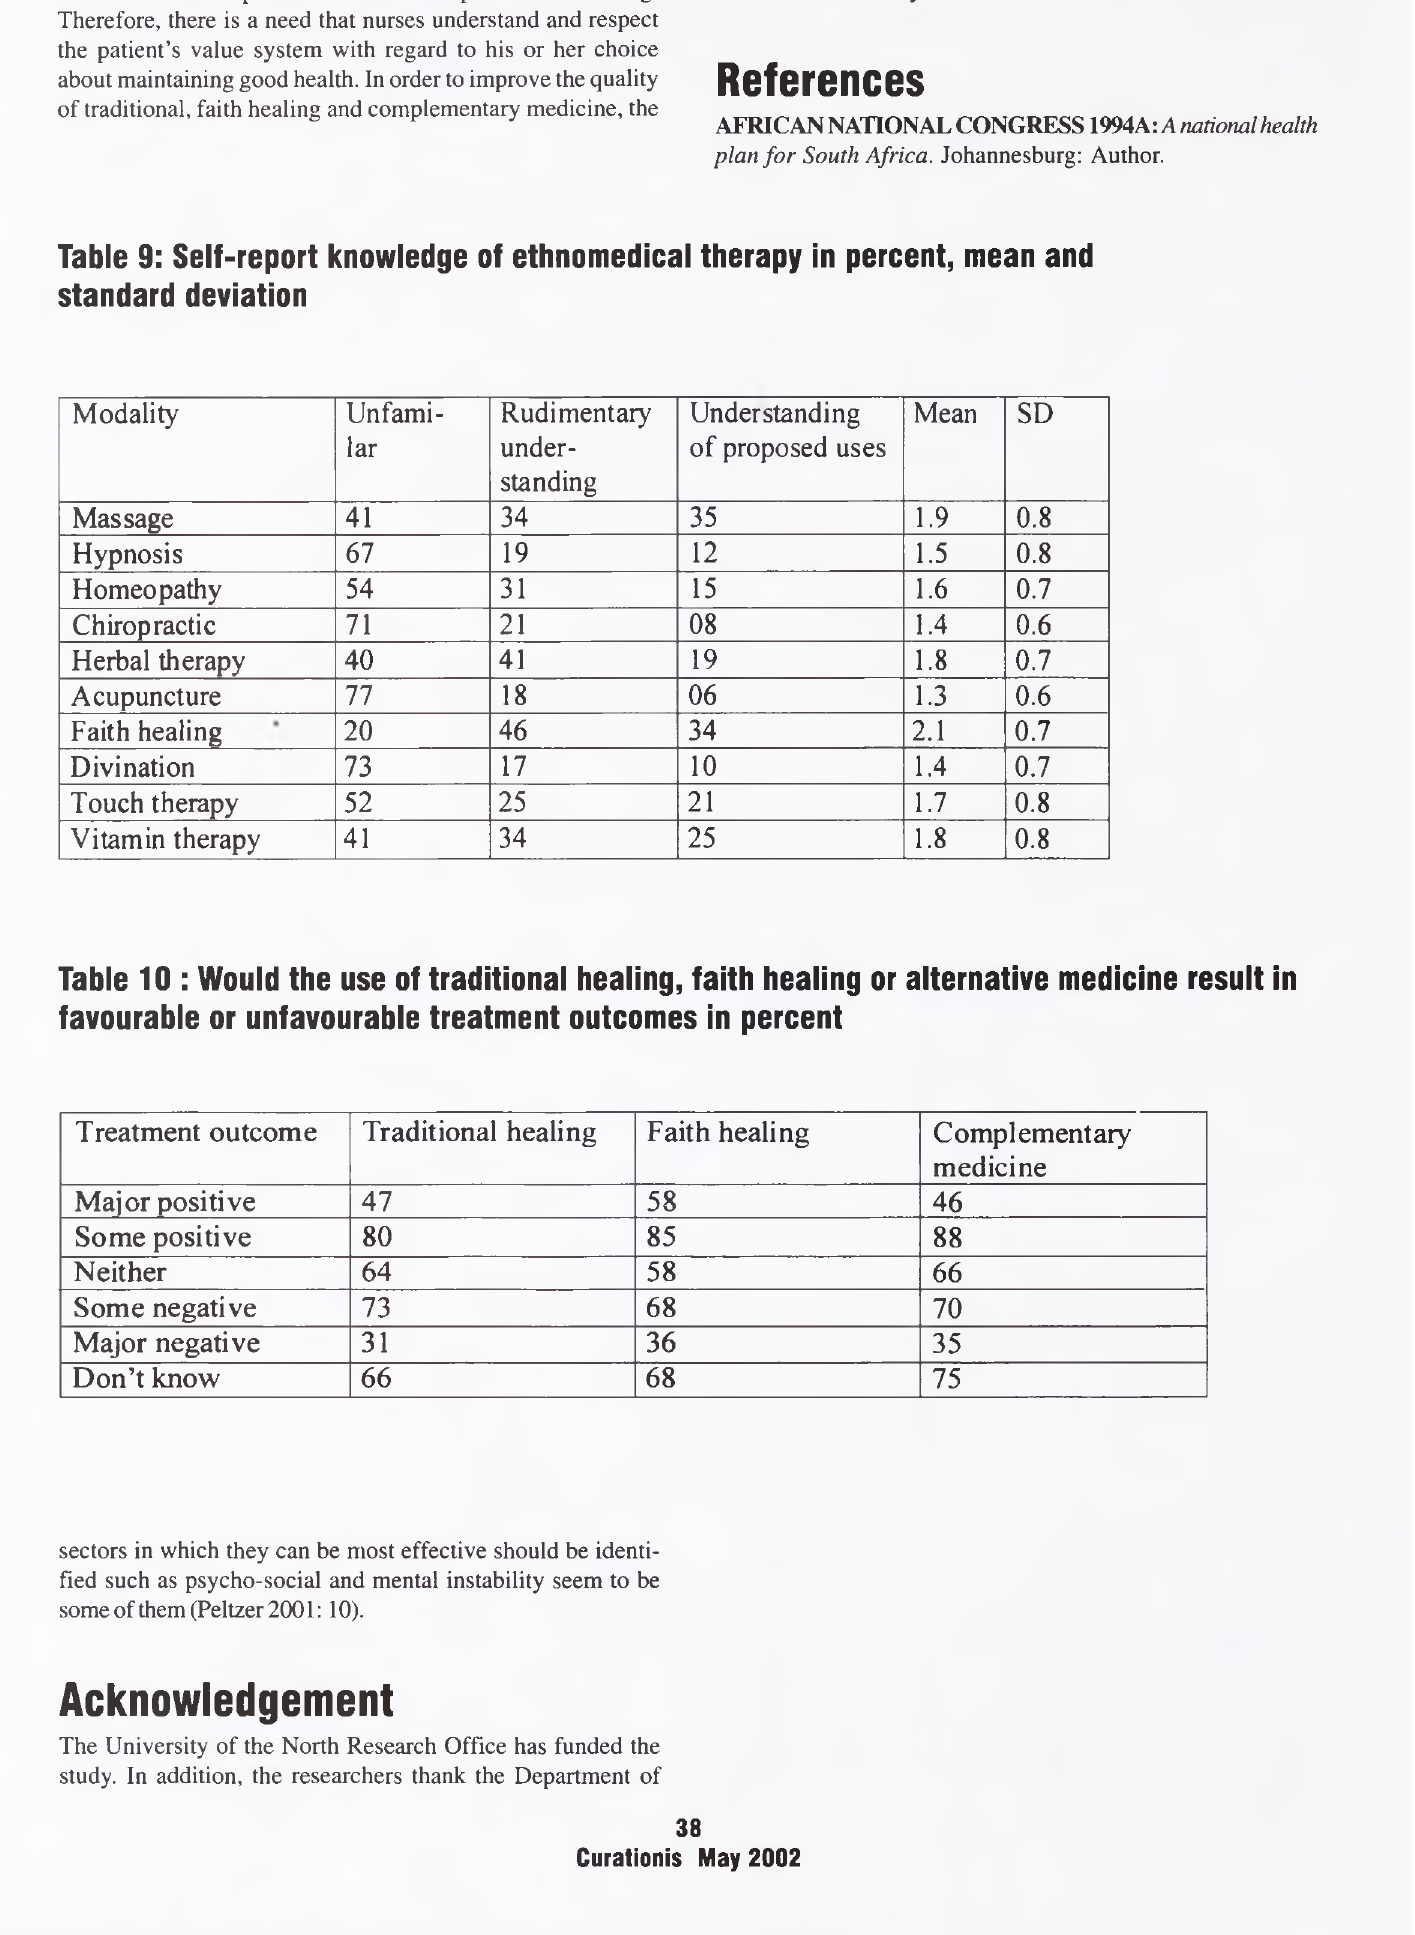
Table 9: Self-report knowledge of ethnomedical therapy in percent, mean and standard deviation